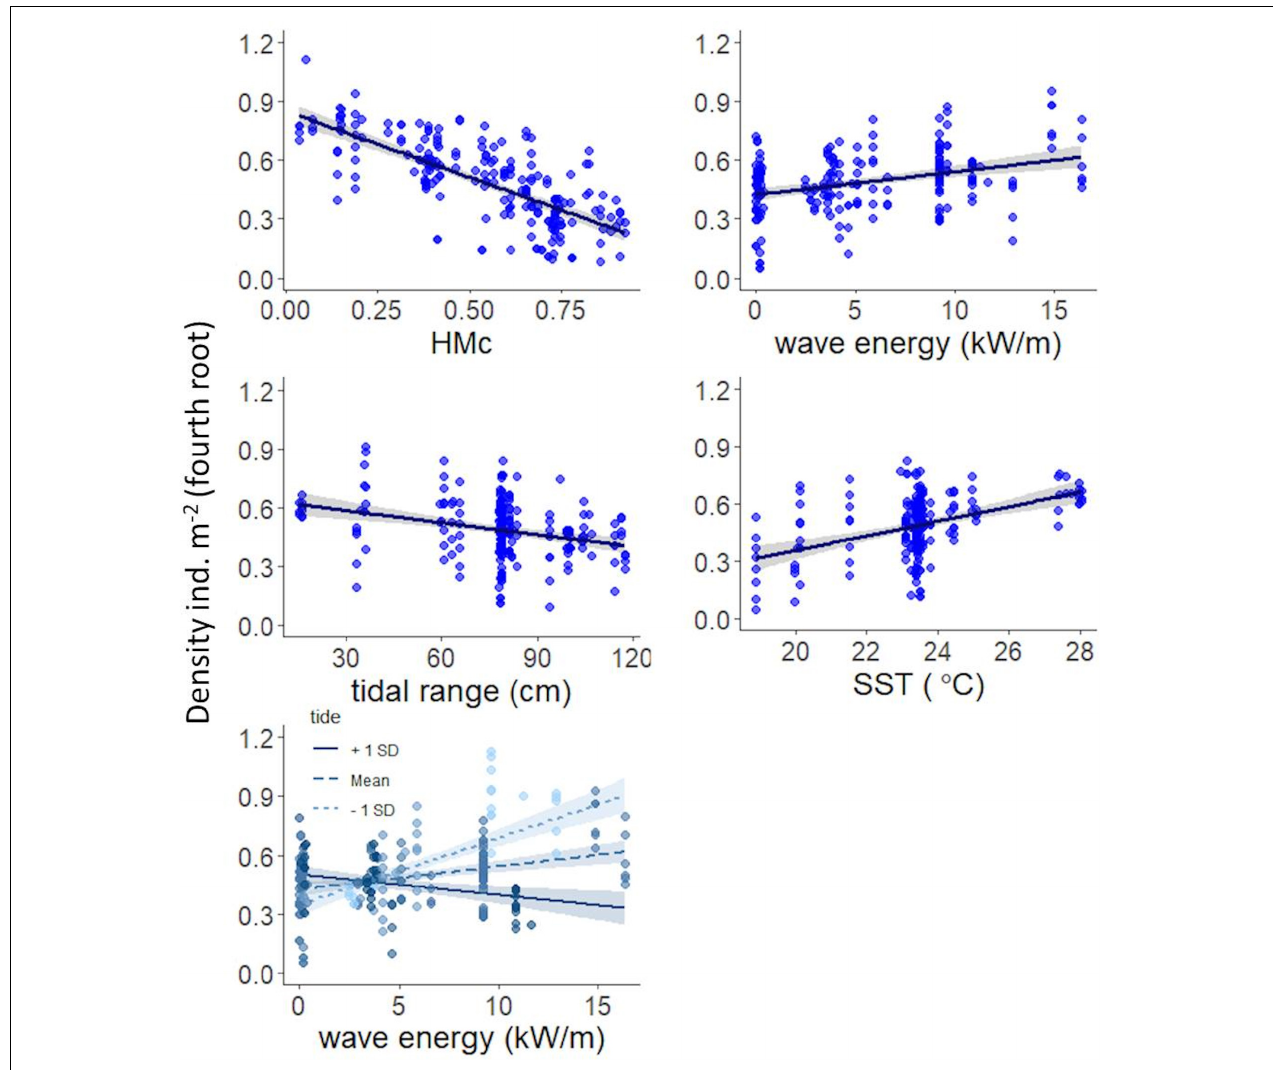
FIGURE 3 | Best model relating burrows density of the ghost crab Ocypode quadrata, environmental variables and cumulative Human Modification (HMc) values. Mean partial effects of HMc, wave energy, tidal range, and SST are shown by solid lines. Mean partial effects for different values of wave energy are shown by solid and dashed lines across distinct values of tidal range. A shaded envelope represents the 95% of confidence